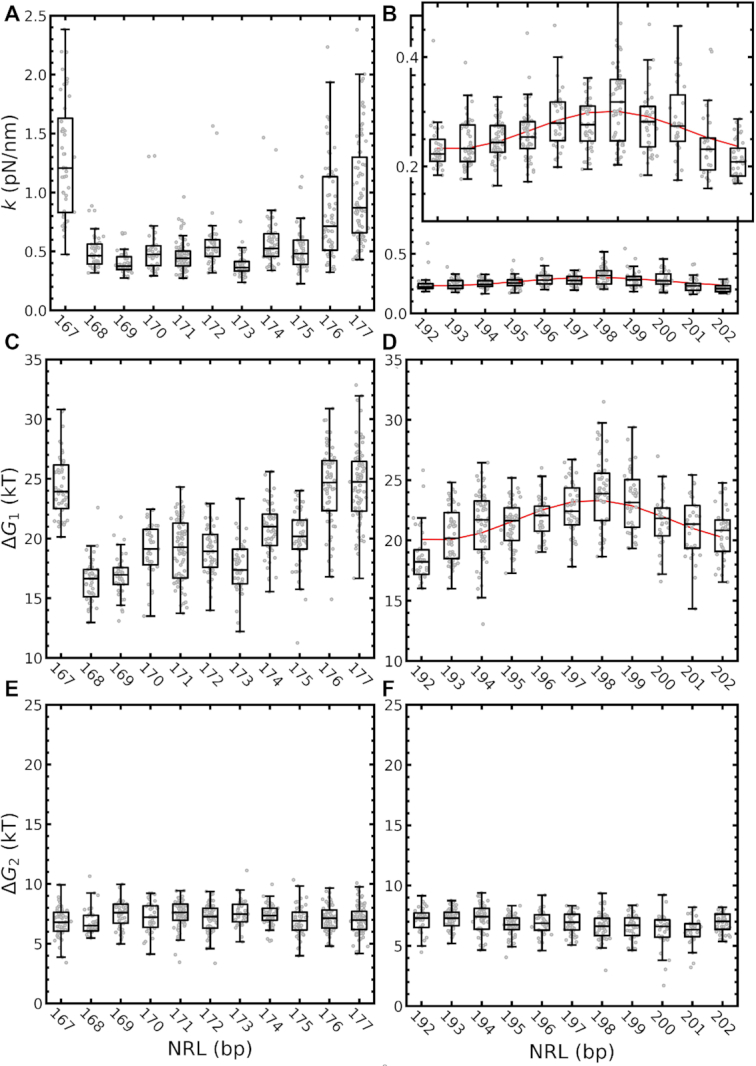
Base pair step parameters feature a 10 bp NRL periodicity. (A) For short NRLs, \documentclass[12pt]{minimal}
\usepackage{amsmath}
\usepackage{wasysym}
\usepackage{amsfonts}
\usepackage{amssymb}
\usepackage{amsbsy}
\usepackage{upgreek}
\usepackage{mathrsfs}
\setlength{\oddsidemargin}{-69pt}
\begin{document}
}{}$k$\end{document} peaked at NRL 167, NRL 176 and NRL 177. Strikingly, the stiffness dropped sharply between NRL 168 and NRL 175, illustrating the sensitivity of \documentclass[12pt]{minimal}
\usepackage{amsmath}
\usepackage{wasysym}
\usepackage{amsfonts}
\usepackage{amssymb}
\usepackage{amsbsy}
\usepackage{upgreek}
\usepackage{mathrsfs}
\setlength{\oddsidemargin}{-69pt}
\begin{document}
}{}$k$\end{document} for linker DNA length. (B) For long NRLs, \documentclass[12pt]{minimal}
\usepackage{amsmath}
\usepackage{wasysym}
\usepackage{amsfonts}
\usepackage{amssymb}
\usepackage{amsbsy}
\usepackage{upgreek}
\usepackage{mathrsfs}
\setlength{\oddsidemargin}{-69pt}
\begin{document}
}{}$k$\end{document} described a gradual modulation which could be captured by a sinusoid, peaking at NRL 198 (\documentclass[12pt]{minimal}
\usepackage{amsmath}
\usepackage{wasysym}
\usepackage{amsfonts}
\usepackage{amssymb}
\usepackage{amsbsy}
\usepackage{upgreek}
\usepackage{mathrsfs}
\setlength{\oddsidemargin}{-69pt}
\begin{document}
}{}$k\ = \ 0.3 \pm 0.1$\end{document} pN/nm). (C) \documentclass[12pt]{minimal}
\usepackage{amsmath}
\usepackage{wasysym}
\usepackage{amsfonts}
\usepackage{amssymb}
\usepackage{amsbsy}
\usepackage{upgreek}
\usepackage{mathrsfs}
\setlength{\oddsidemargin}{-69pt}
\begin{document}
}{}$\Delta {G_1}$\end{document} showed a similar trend as \documentclass[12pt]{minimal}
\usepackage{amsmath}
\usepackage{wasysym}
\usepackage{amsfonts}
\usepackage{amssymb}
\usepackage{amsbsy}
\usepackage{upgreek}
\usepackage{mathrsfs}
\setlength{\oddsidemargin}{-69pt}
\begin{document}
}{}$k$\end{document}; for short linker lengths peak values were found for NRL 167, NRL 176, and NRL 177 and dropped in between. (D) Also for long linker lengths \documentclass[12pt]{minimal}
\usepackage{amsmath}
\usepackage{wasysym}
\usepackage{amsfonts}
\usepackage{amssymb}
\usepackage{amsbsy}
\usepackage{upgreek}
\usepackage{mathrsfs}
\setlength{\oddsidemargin}{-69pt}
\begin{document}
}{}$\Delta {G_1}$\end{document} oscillated with a period of 10.4 bp and peaked at NRL 198, similar to \documentclass[12pt]{minimal}
\usepackage{amsmath}
\usepackage{wasysym}
\usepackage{amsfonts}
\usepackage{amssymb}
\usepackage{amsbsy}
\usepackage{upgreek}
\usepackage{mathrsfs}
\setlength{\oddsidemargin}{-69pt}
\begin{document}
}{}$k$\end{document}. (E, F) As expected for non-interacting nucleosomes, \documentclass[12pt]{minimal}
\usepackage{amsmath}
\usepackage{wasysym}
\usepackage{amsfonts}
\usepackage{amssymb}
\usepackage{amsbsy}
\usepackage{upgreek}
\usepackage{mathrsfs}
\setlength{\oddsidemargin}{-69pt}
\begin{document}
}{}$\Delta {G_2}$\end{document} did not change with NRL.